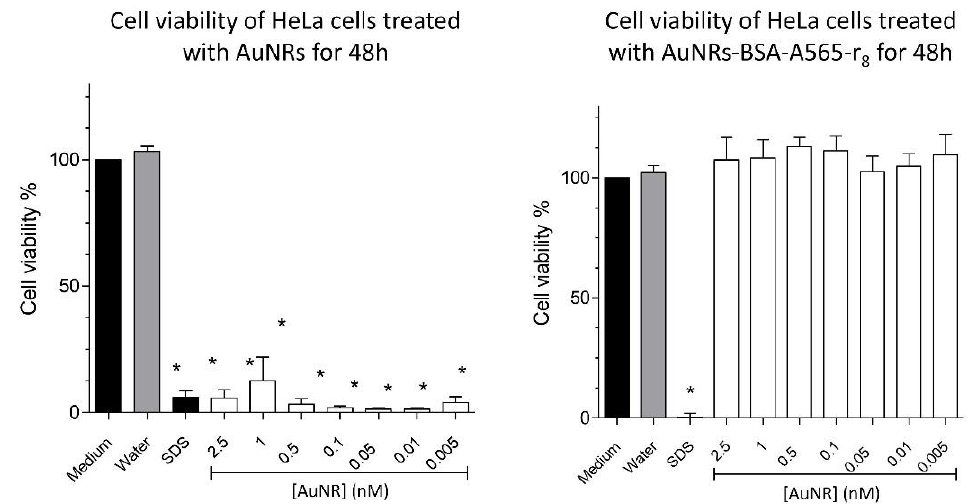
Figure 4. Effect of AuNRs and AuNR-BSA-r 8 incubated for 24 h on cell viability of HeLa cells at 48 h. The average values for n = 4 experiments are shown with error bars representing the SEM. * Significant difference according to Tukey’s test p < 0.05 compared to medium control.